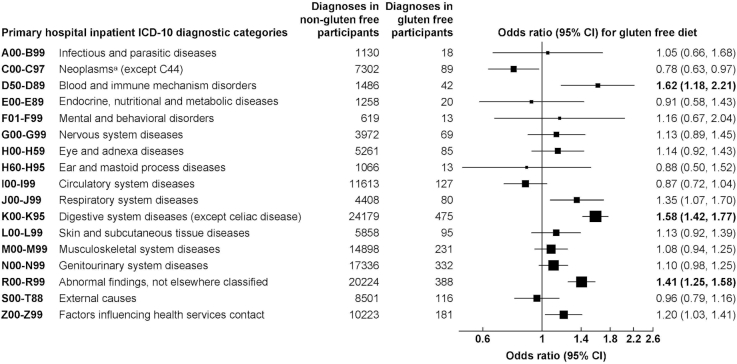
Association of hospital inpatient diagnoses by ICD-10 chapter with following a gluten-free diet. Models are adjusted for age, sex, ethnicity, Townsend deprivation score, education, smoking, alcohol, physical activity, and BMI. Information on cancers was obtained from cancer registry data and not hospital inpatient records. Bold values indicate associations that are significant at the Bonferroni corrected level P < 0.003 (allowing for 17 tests). ICD-10, International Classification of Diseases, 10th revision.